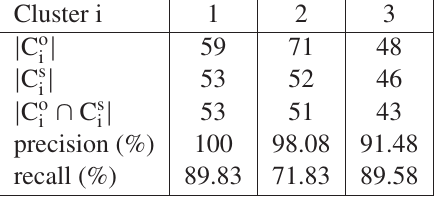
Table 1. Clustering results of shrinking algorithm on wine data.